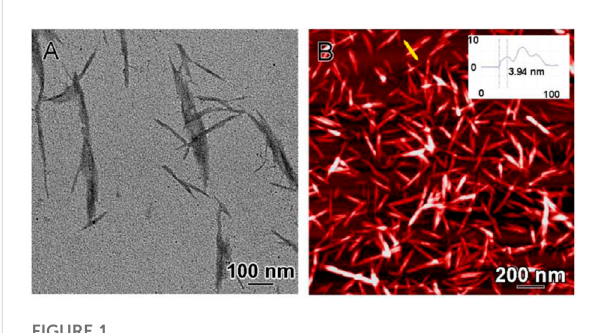
FIGURE 1 CNC morphologic and dimensional characterization. (A) Characterization of CNC by TEM and (B) AFM: inset shows the cross- sectional height pro fi le along the yellow line which suggests multi- layered stacking of CNC — the thickness (height) of single layer is around 4 nm and the width is approximately 6 nm